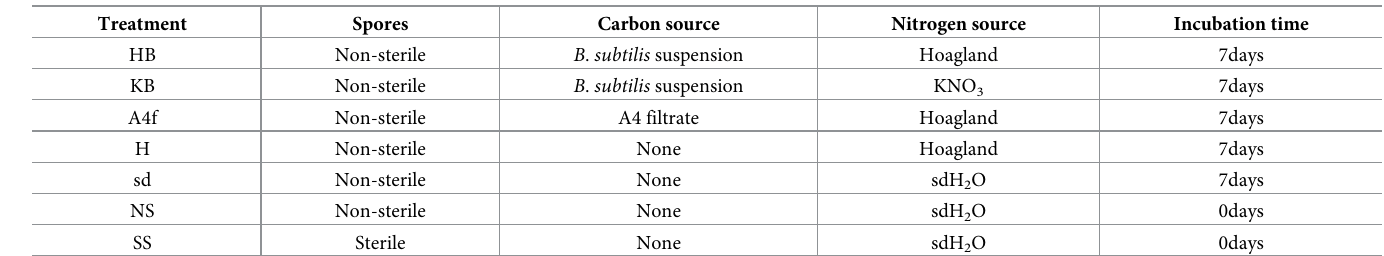
Table 1. The treatments used for bacterial community